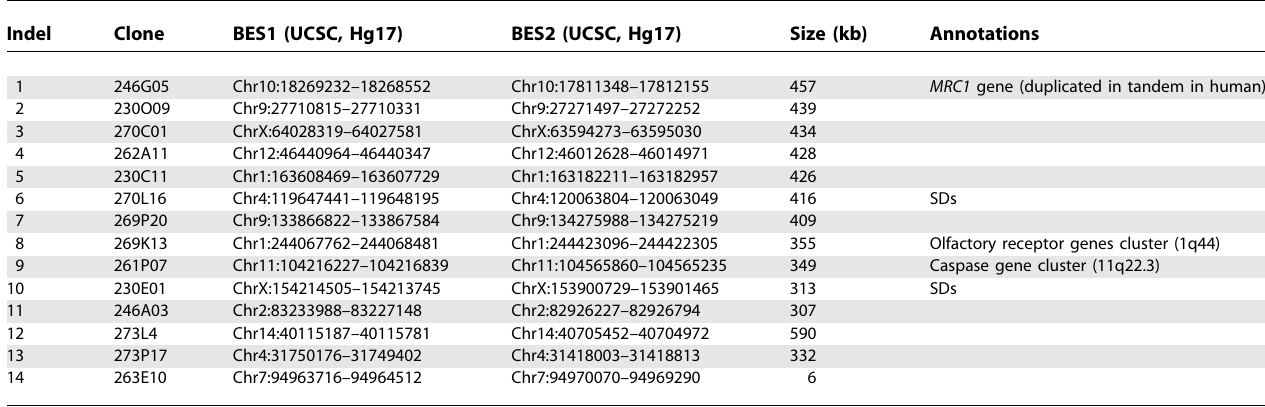
Table 4. Gibbon BAC Clones Spanning